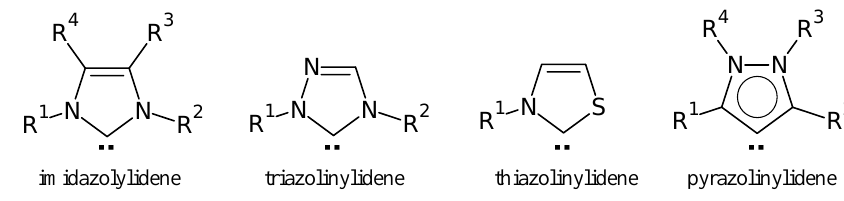
Figure 1. Structures of NHCs.